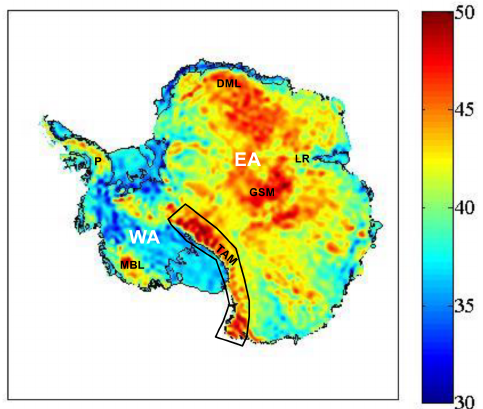
Figure 5. Estimation of crustal thickness (in km) from GOCE gravity observations. Geographical locations mentioned in the text are Dronning Maud Land (DML), Lambert Rift (LR), Gamburtsev Subglacial Mountains (GSMs), Transantarctic Mountains (TAMs), Marie Byrd Land (MBL) and the peninsula (P). The large TAMs separate East Antarctica (EA) from West Antarctica